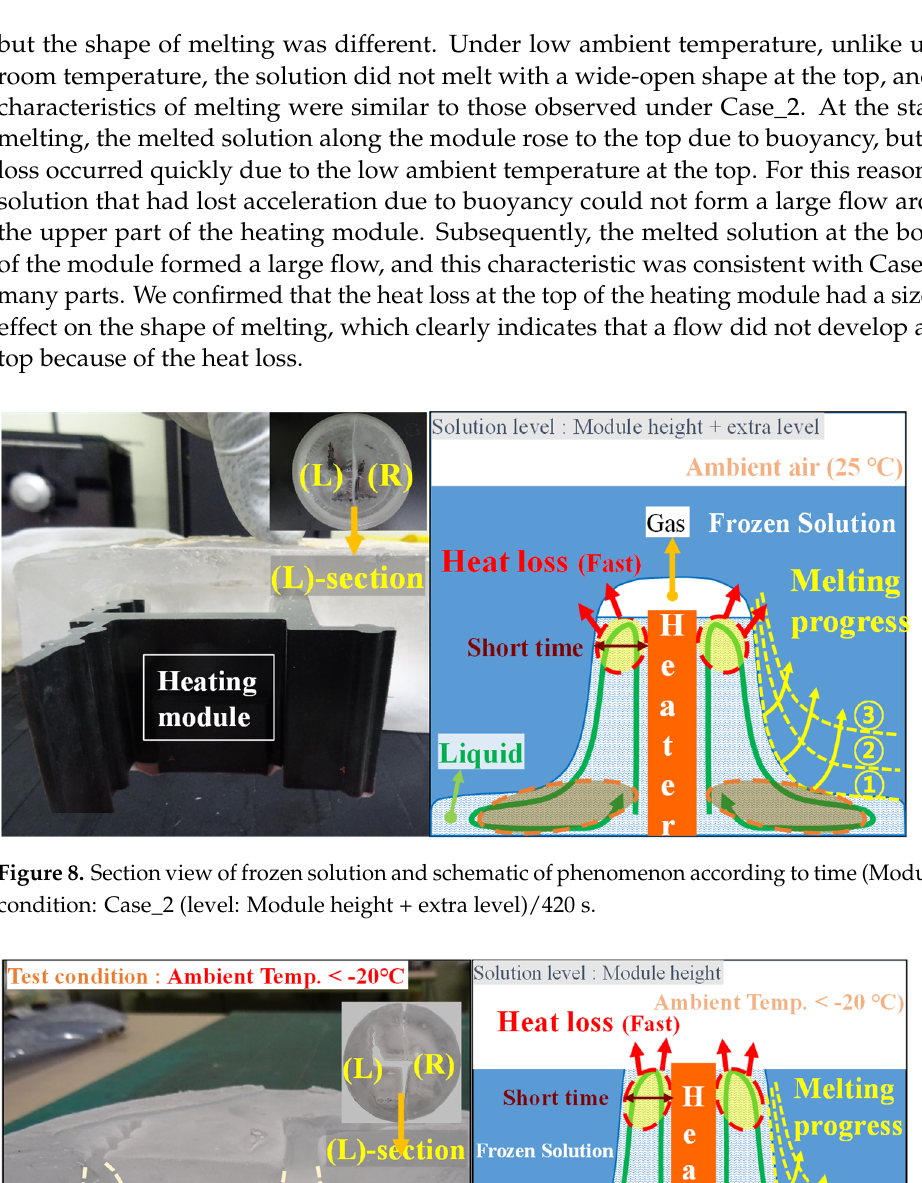
Figure 9. Section view of frozen solution, and schematic of phenomenon with time (Module_1); condition: Case_1 (level: Module height)/ambient temp. < − 20 °C/600 s.